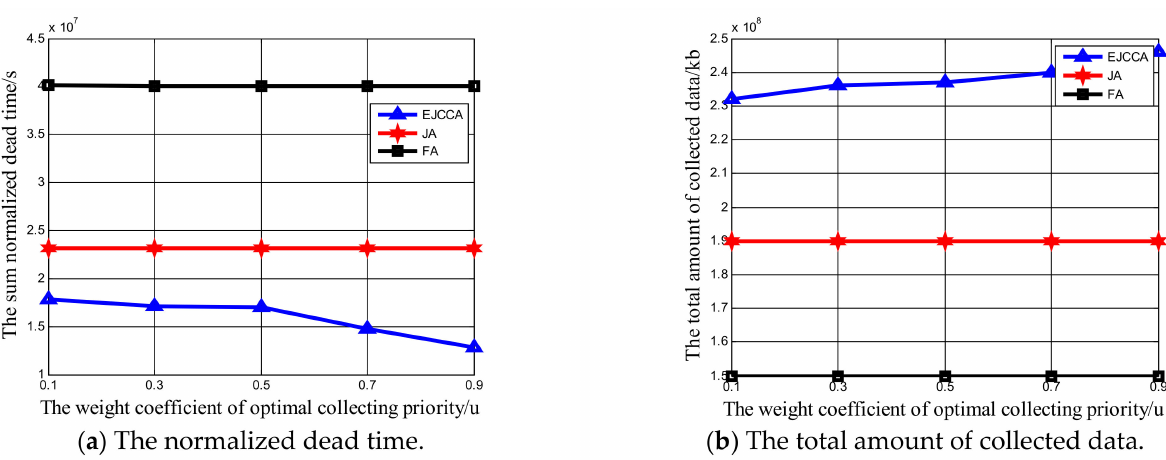
Figure 8. The influence of weight coefficient of optimal collecting priority on the network